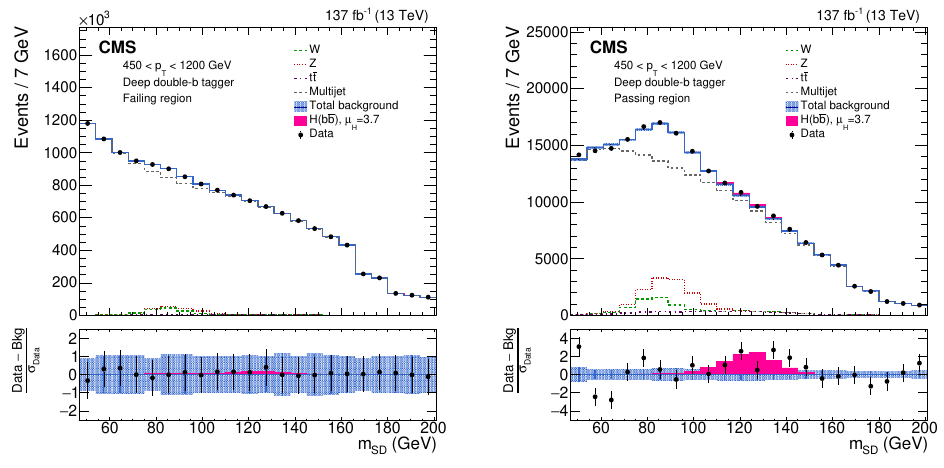
Figure 3 . The observed and fitted background m distributions for the DDBT failing (left) and SD passing (right) regions, combining all the p categories, and three data collection years. The fit is T performed under the signal-plus-background hypothesis with one inclusive H(bb) signal strength parameter floating in all the p categories. Because of the finite ρ acceptance, some m bins T SD within a given p category may be removed, giving rise to the steps at 166 and 180 GeV. The T shaded blue band shows the systematic uncertainty in the total background prediction. The bottom panel shows the difference between the data and the total background prediction, divided by the statistical uncertainty in the data. In the failing region, the background model includes a free parameter for each m bin, ensuring the nearly perfect agreement between the model and the SD data — this agreement is imperfect because the passing region is fit simultaneously and the global best fit is a balance between the two regions. Thus, the statistical uncertainty in the data gives rise to the systematic uncertainty in the background prediction. This is reflected in the fact that the error bar for the data and the uncertainty band for the background are approximately equal in